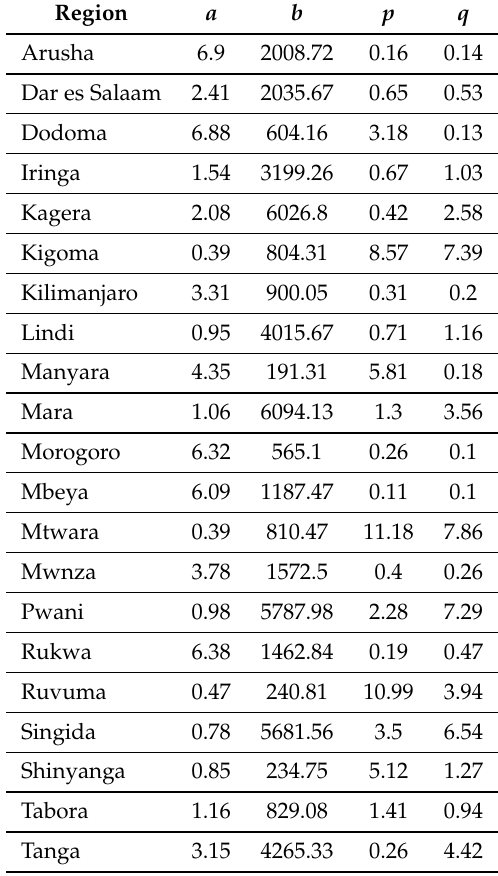
Table 3. The estimated parameters of the income distribution function GB2 for each